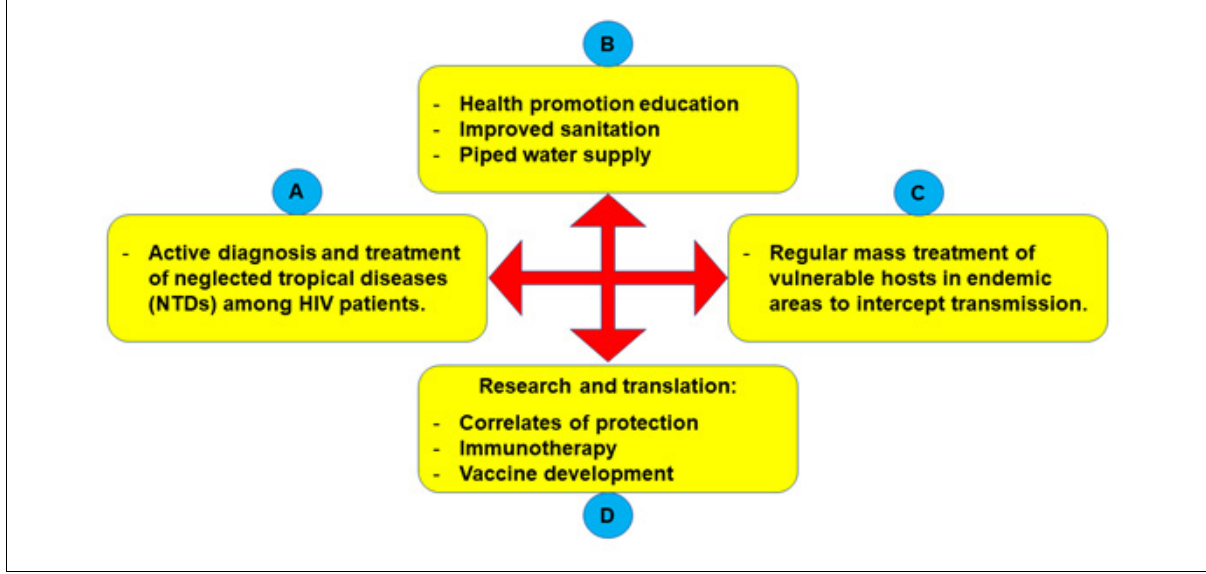
Figure 1: A four-pronged approach for successful mitigation against the burden of helminth co-infections with